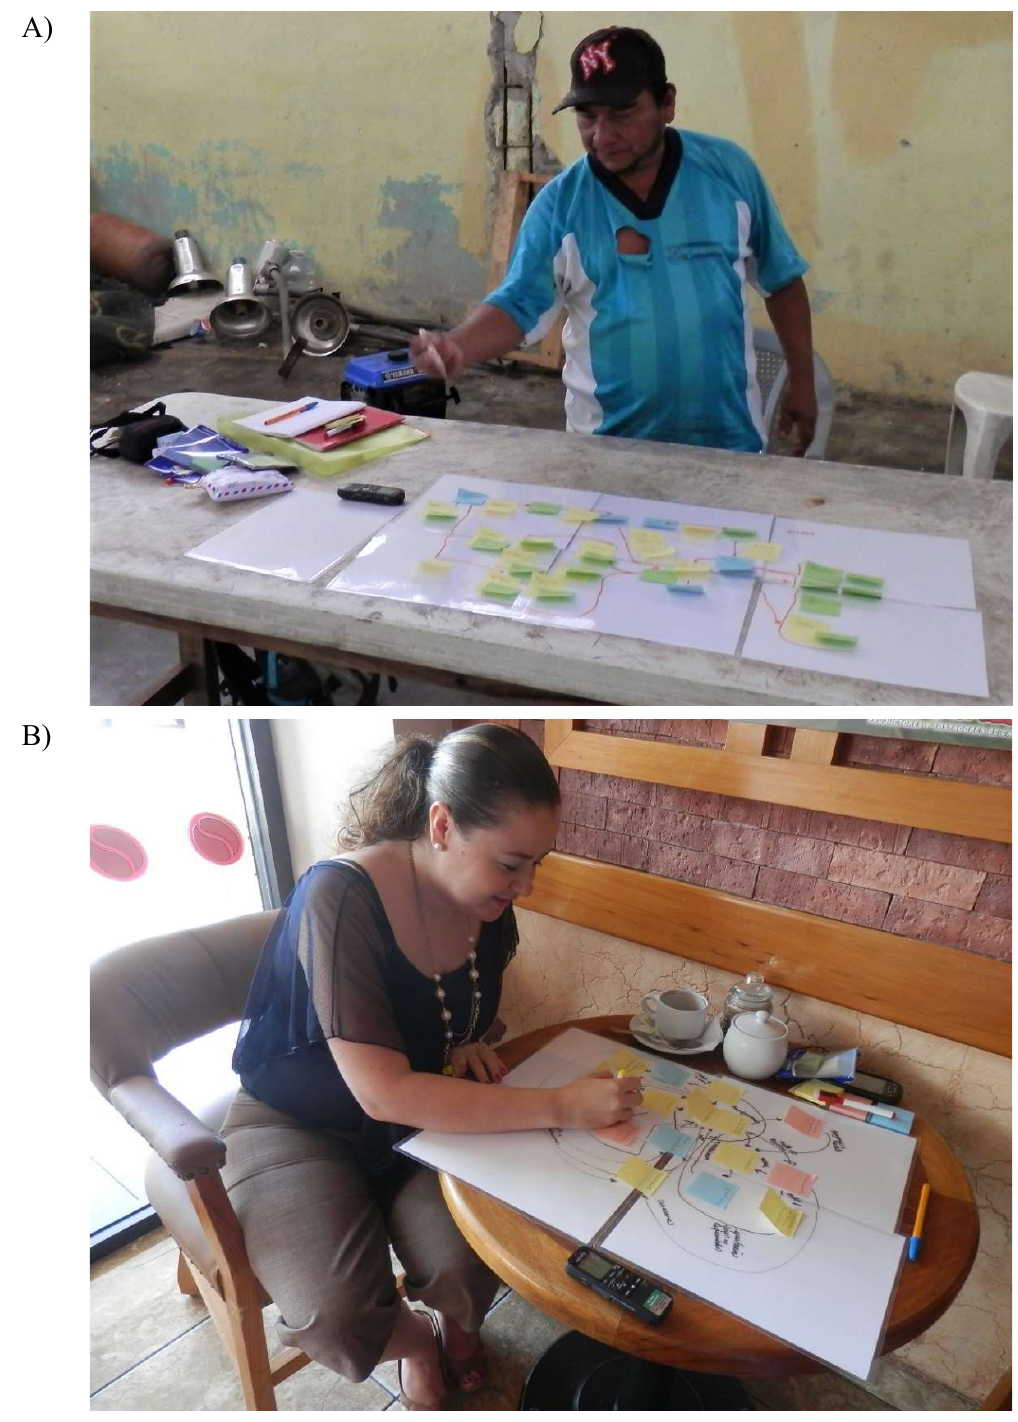
Fig. A1.1. Mental model drawing by A) a leader of a fishing cooperative, and B) a representative of an